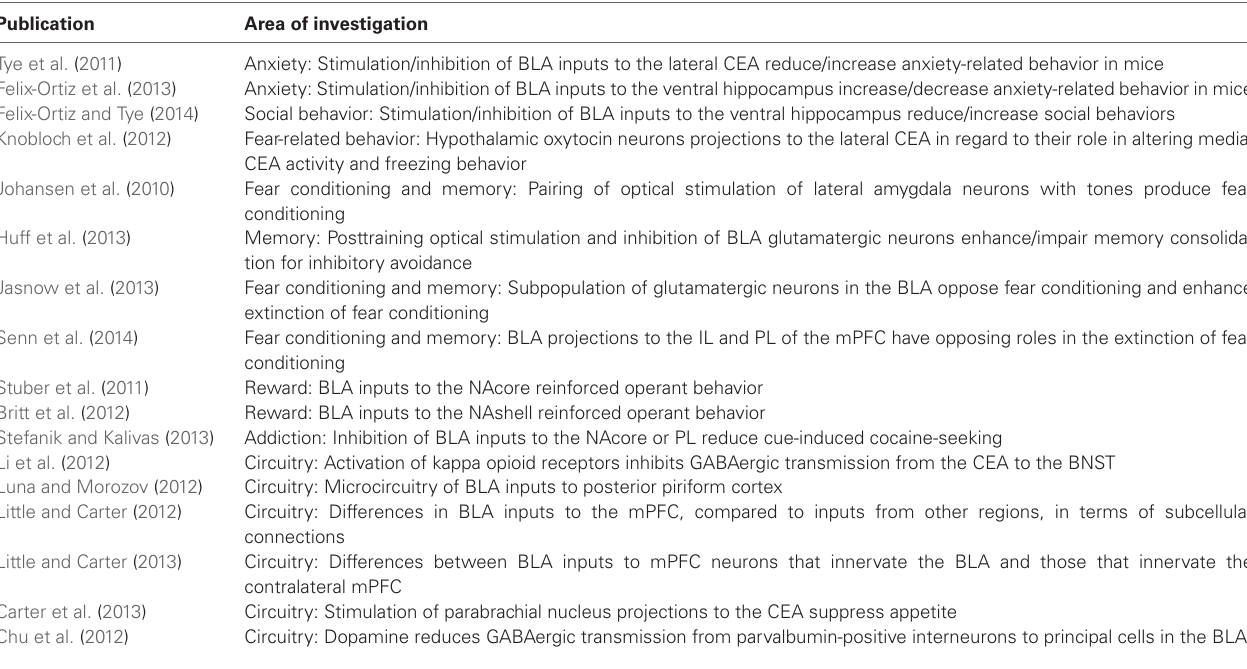
Table 1 | Description of reviewed publications using optogenetics in investigations of the amygdala